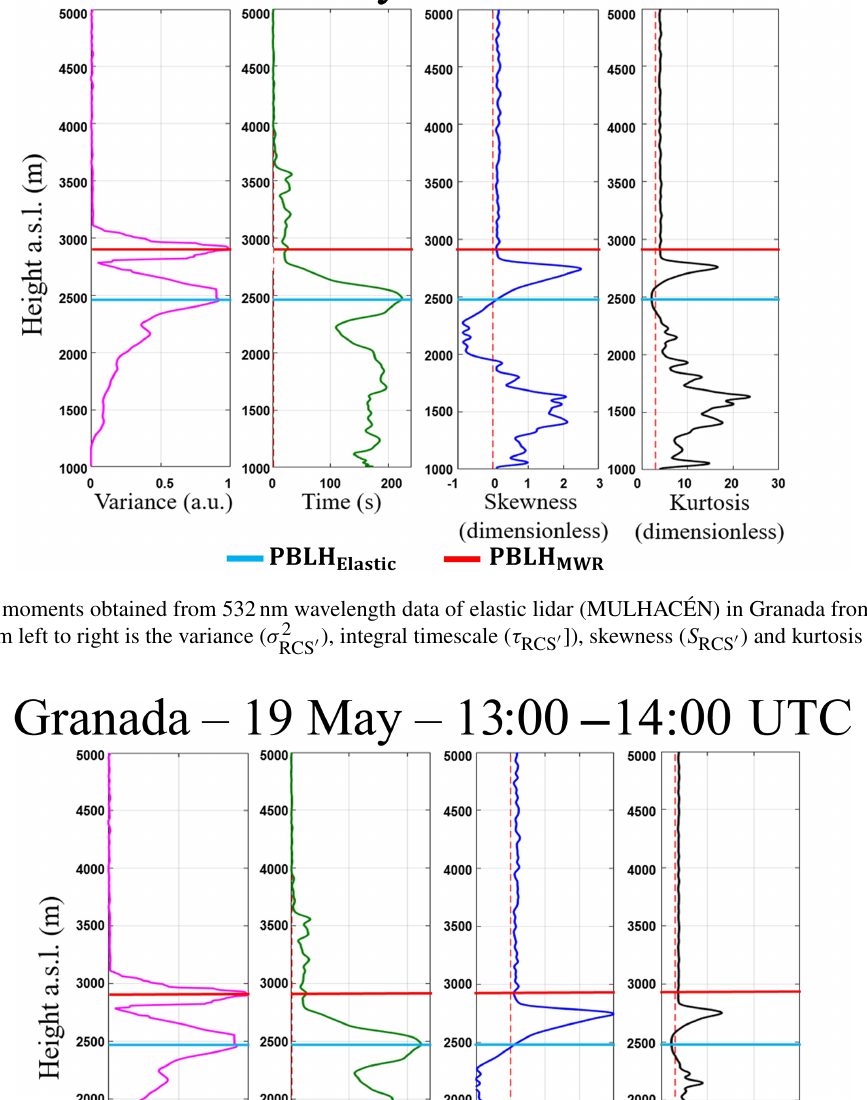
herent in the variance method (Kovalev and Eichinger,